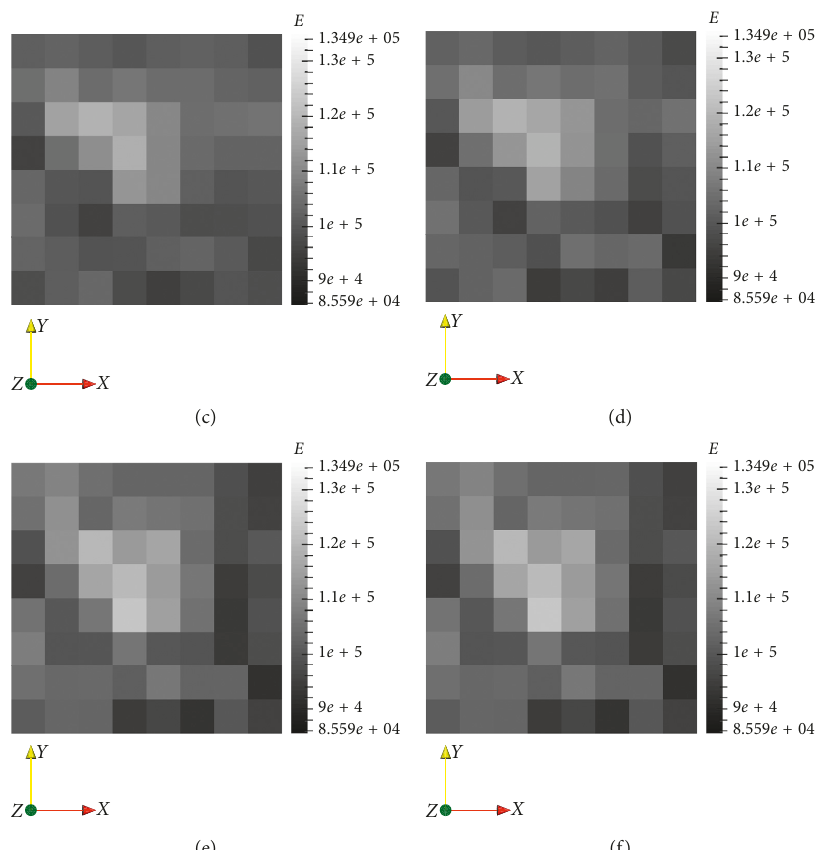
Figure 6: Reference field (a), initial estimation (i.e., ensemble mean) (b), updated estimation after excavating the 1st layer (c), updated estimation after excavating the 2nd layer (d), updated estimation after excavating the 3rd layer (e), and updated estimation after excavating the 4th layer